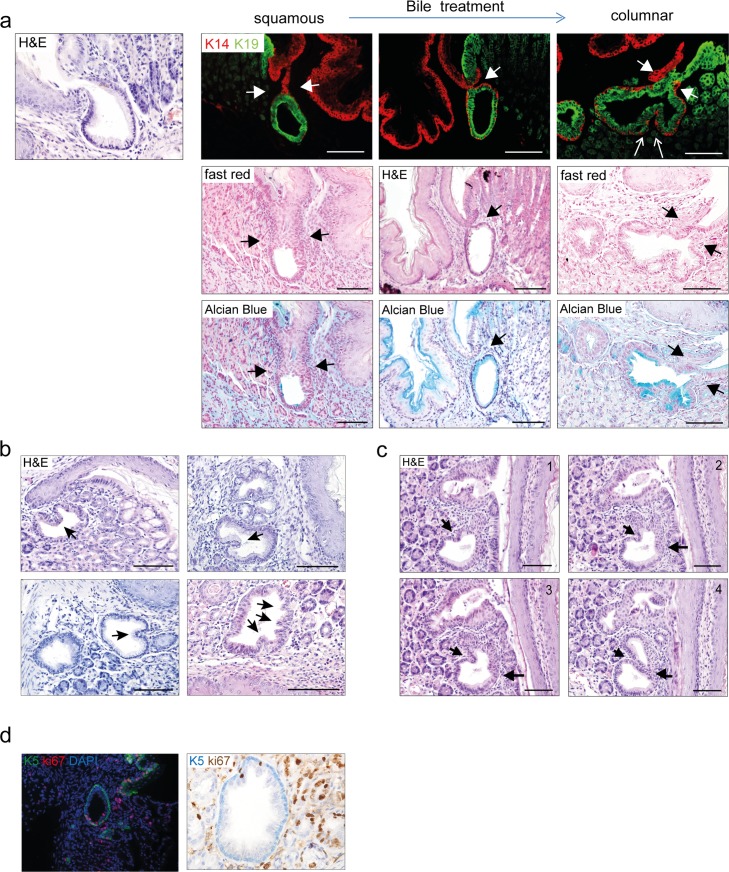
Glycine-conjugated BAs cause budding and branching of MLGS followed by crypt fission.[a] K19+ cuboidal cells in the proximal two-thirds (green), and K14+ stratified squamous epithelium (red) towards the luminal surface in the MLGS at the SCJ. After glycine-conjugated BA treatment the MLGS extend towards the surface and align with the columnar surface epithelium (closed arrows). Budding of the inner layer after bile treatment (open arrows). [b] H&E staining of MLGS at the SCJ show budding of the inner layer projecting in the lumen of the gland (arrows). [c] Serial sections of the SCJ in mice treated with bile shows budding, which are projecting into the lumen of the MLGS, resulting in the formation of two separate glands by the process of crypt fission. [d] MLGs at the SCJ showing sparse ki67+ proliferating cells. (Scale bars 100μm).